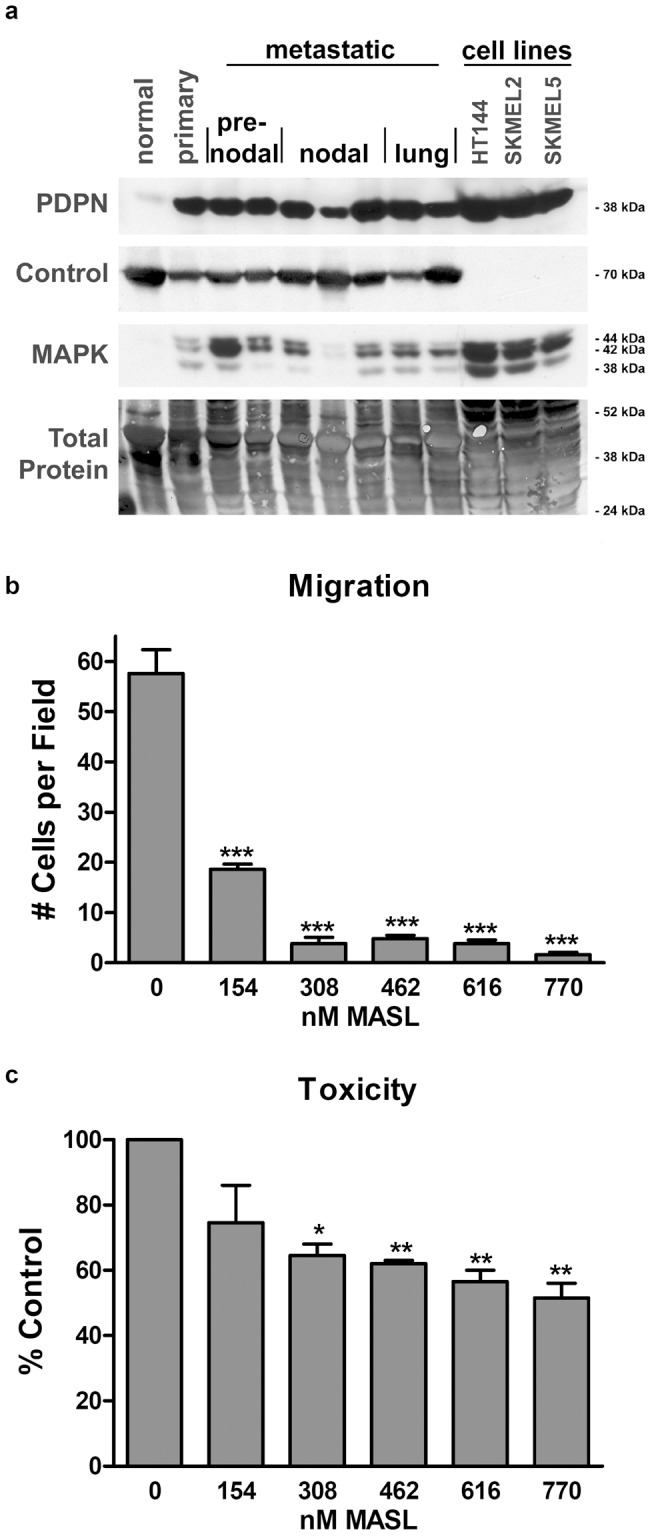
Human melanoma cells express PDPN and respond to MASL.(a) PDPN was detected by Western blotting of protein (15 µg per lane) from a variety of human specimens including normal skin, primary melanoma, melanoma in transit prior to lymph node metastasis, nodal metastasis, lung metastasis, and three melanoma cells lines (HT-144, SK-MEL-2, SK-MEL-5). Detection of MAPK and nonspecific bands by Western blotting and India ink staining of membranes is also shown to verify equal loading of these samples from different patients and cell lines. (b) Wound healing migration assays were performed on confluent HT-144 monolayers treated with MASL as indicated. Data are shown as the number of cells that migrated into a 400×500 micron area along the center of the wound in 24 hours (mean + SEM, n = 5). (d) HT-144 cells were treated with MASL, and cell viability was evaluated by Alamar blue assay. Data are shown as percent of nontreated cells (mean + SEM, n = 2). Single, double, and triple asterisks indicate p<0.05, p<0.01, and p<0.001 compared to untreated cells, respectively.